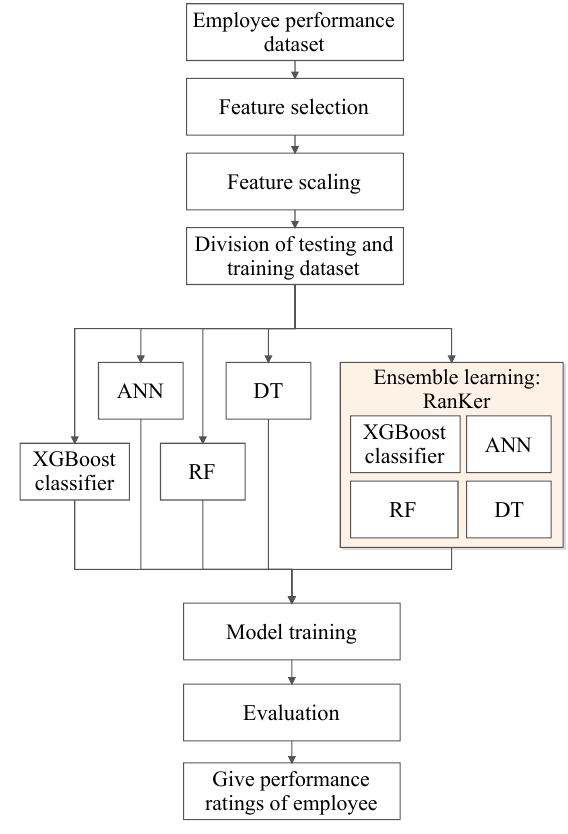
Figure 1. System